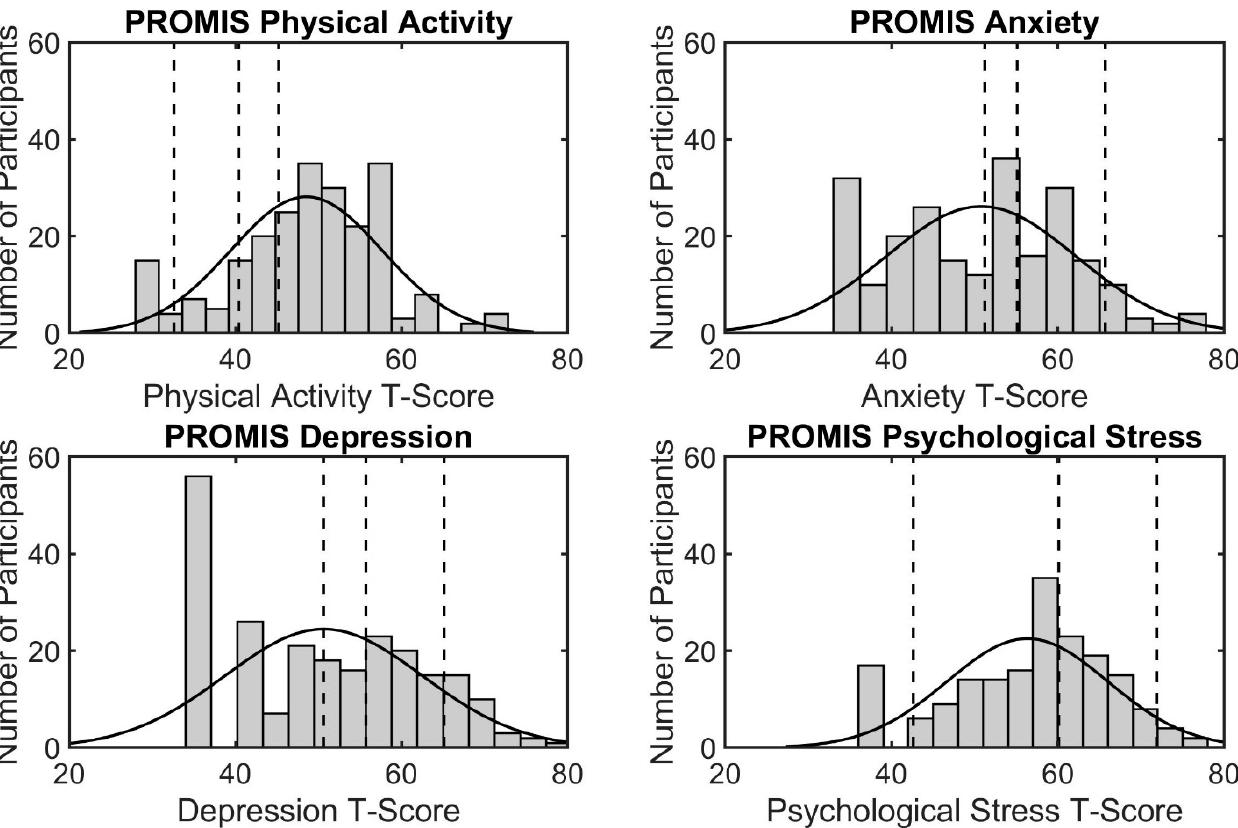
Figure 1. Distribution of T-scores for each of the four PROMIS measures. For each figure, the X axis represents PROMIS standardized T-score and the Y-axis represents the number of participants. The vertical dashed lines depict the cut-points for each category (normal, mild, moderate, severe (physical activity, anxiety, depression) or low, average, high, very high (psychological stress)).